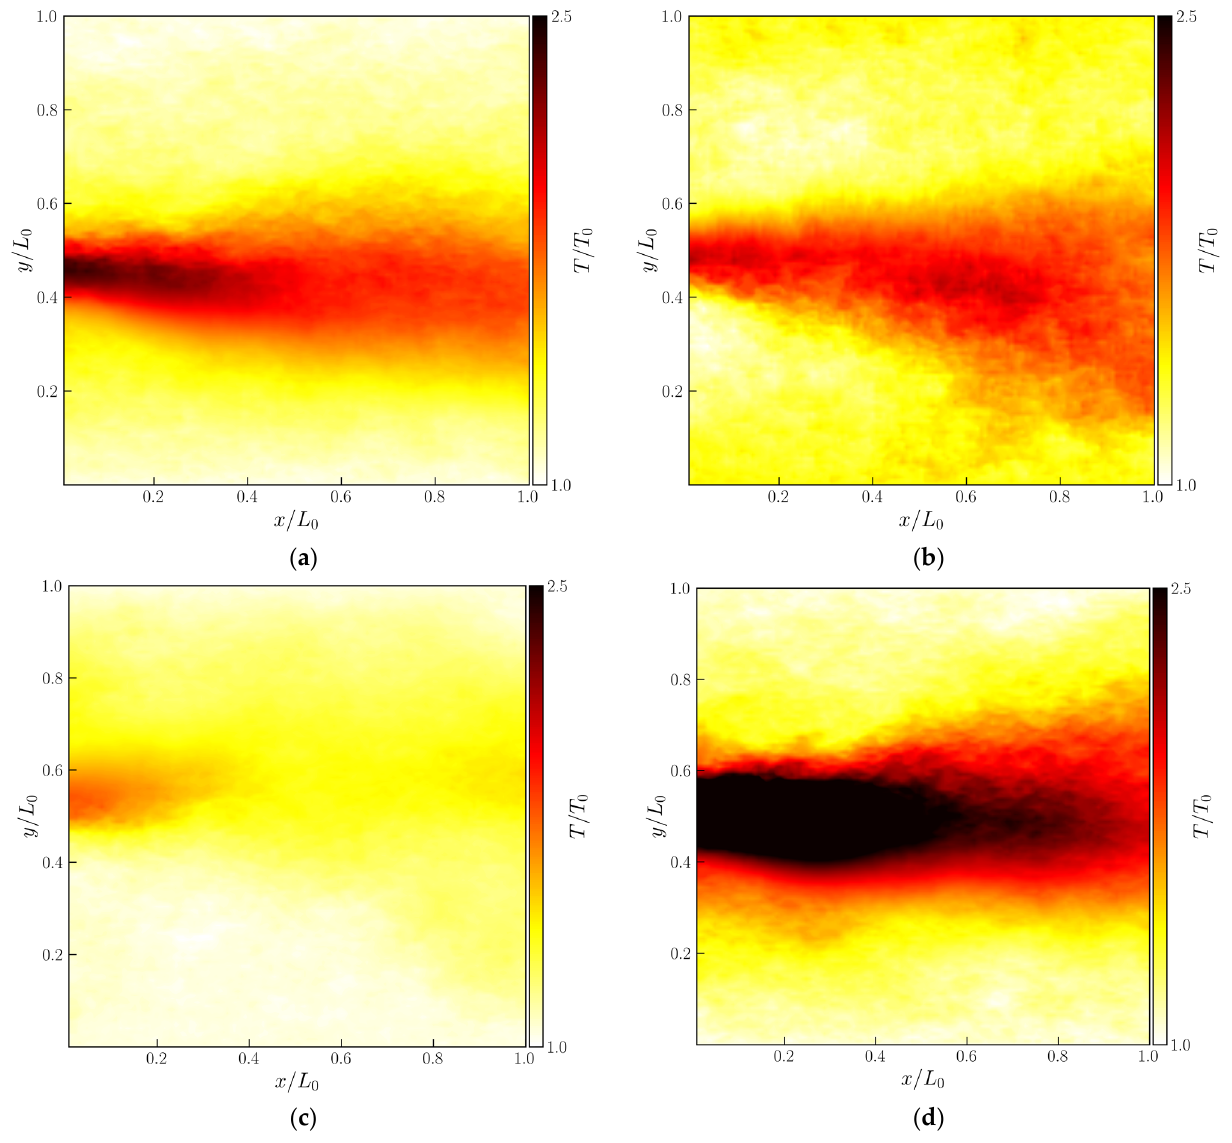
Figure 7. Plasma-induced flow temperature field, at steady state, for actuators with 1 mm thickness of, ( a ) Kapton; ( b ) PIB rubber; ( c ) Teflon. ( d ) PMMA. All operating at 9 kV pp and 24 kHz.